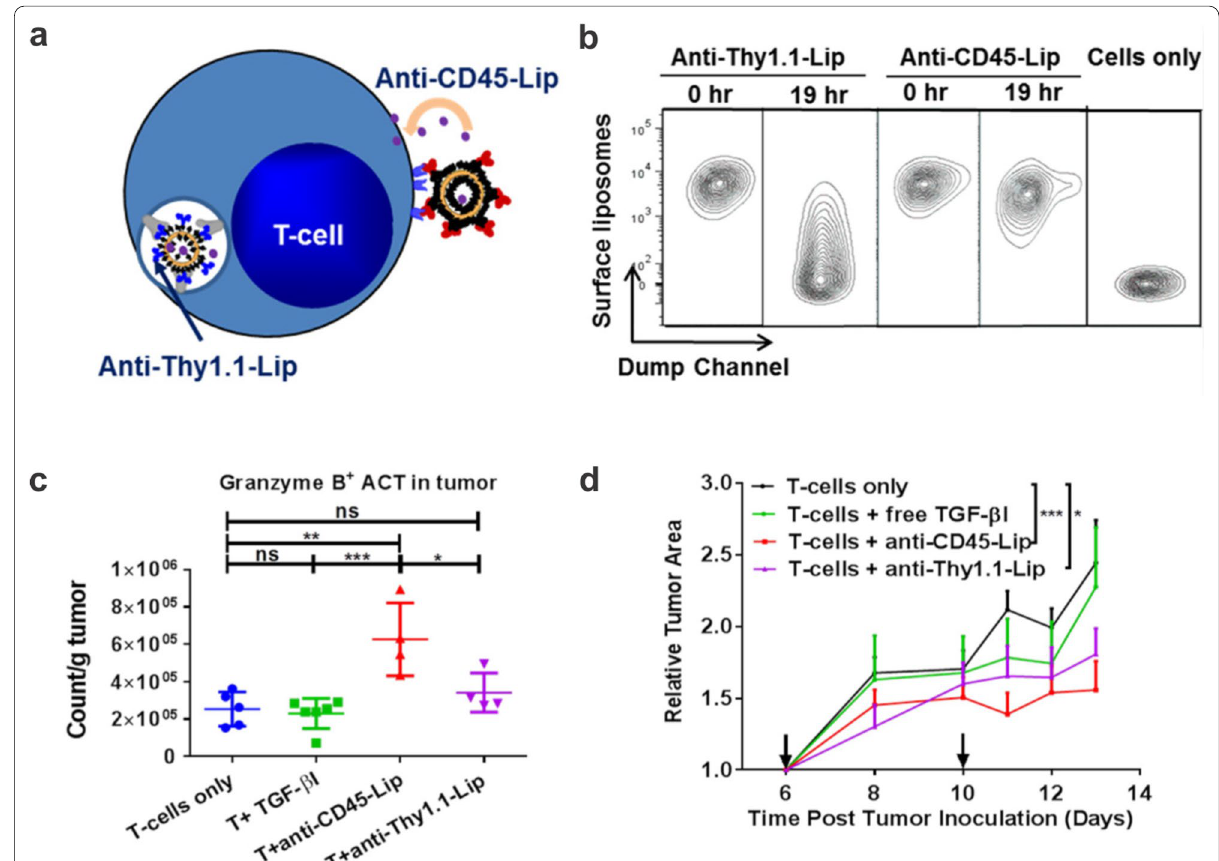
Fig. 4 Surface engineering of T cells with nanoparticles. a Schematic diagram depicting the liposomes anchoring to either CD45 or Thy1.1 receptor on T cells. b Flow cytometry showed that remaining liposomes on cell surface‑bound to CD45, a non‑internalizing receptor, were significantly greater than those bound to Thy1.1, an internalizing receptor. c T cells loaded with anti‑CD45 liposomes containing TGF‑β inhibitors led to greater infiltration in tumors. d CD45 bound liposomes decreased the tumor size of B16F10 tumors compared to either free or Thy1.1 bound liposomes. Reproduced with permission from ref